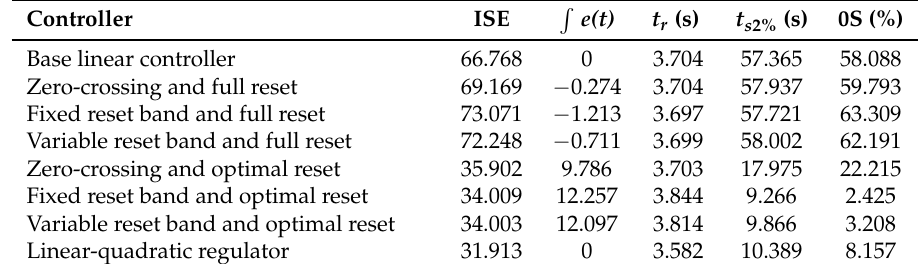
Table 4. Simulation characteristics of the controllers.